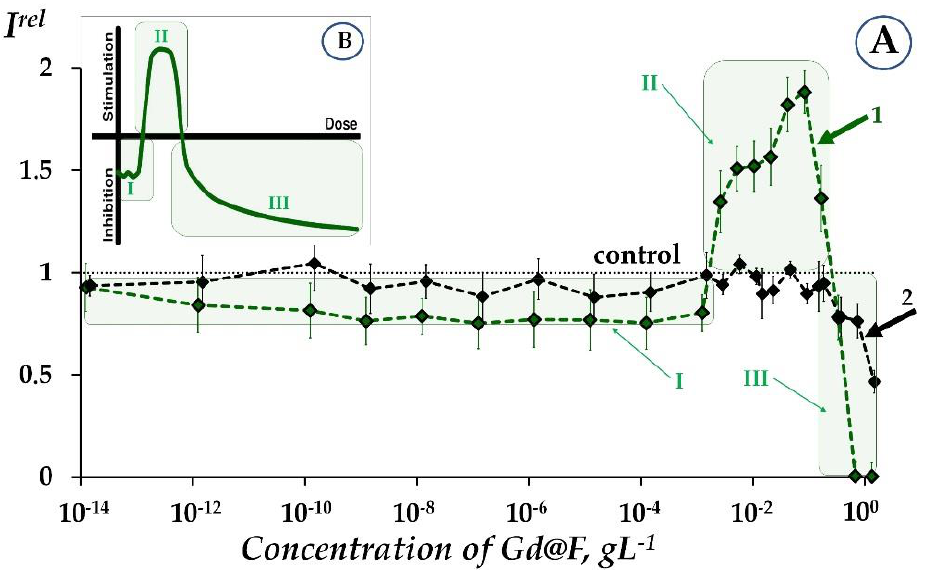
Figure 1. ( A ) Relative bioluminescence intensity, I rel , at different concentrations of Gd-containing fullerenol in bacterial suspension (1) and enzymatic system (2). ( B ) Scheme of hormesis dose–effect model is presented according to Rozhko et al. [10]. Hormetic stages: I—stress recognition, II—physiological activation, III—inhibition of vital functions. The figure was reproduced from Sushko et al. [9].